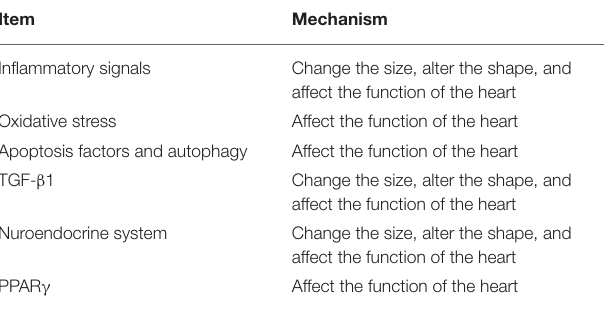
TABLE 2 | Details of the different mechanism on the